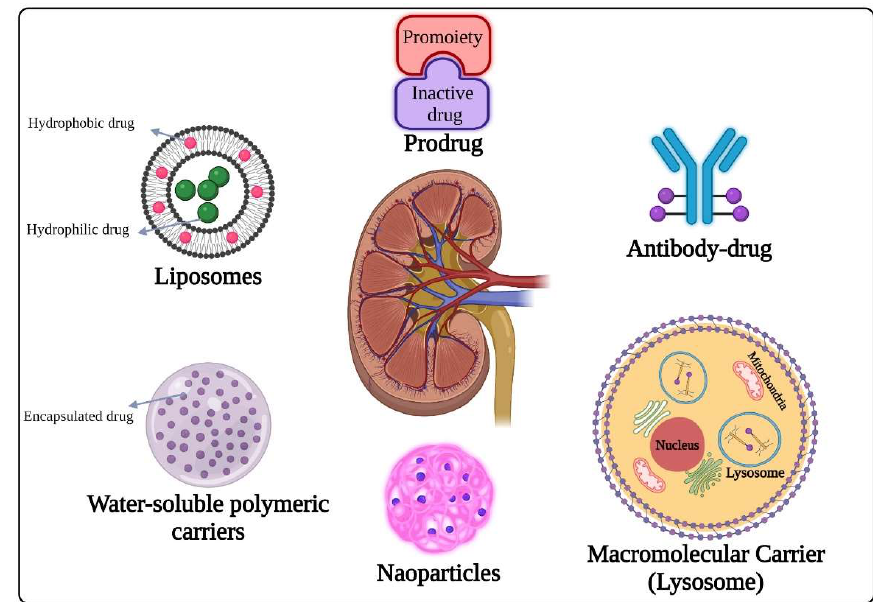
Figure 5. Different strategies of renal drug delivery system.